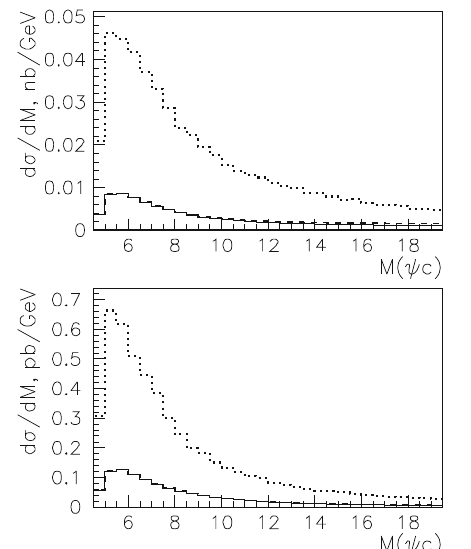
> 20 GeV; dashed curve, p ψ > 20 GeV, T T > 5 GeV, p ∗ > 20 GeV. Lower panel: T T > 50 GeV; dashed curve, p ψ > 50 T T > 20 GeV, p ∗ > 50 GeV T T